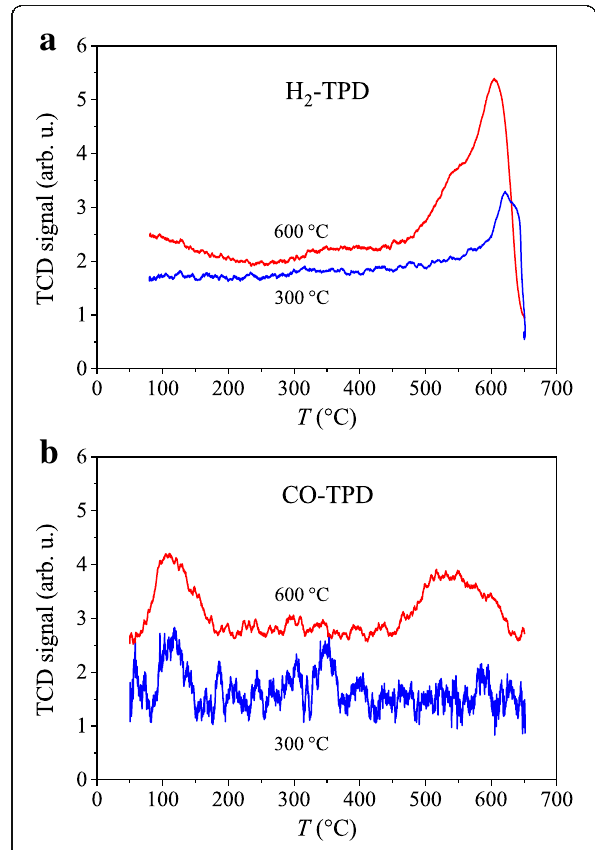
Fig. 2 a H 2 – TPD and b CO – TPD profiles of the Ga 3 Ni 2 catalyst reduced at 300 or 600 °C, respectively. Vertical axis shows the signal from the thermal conductivity detector